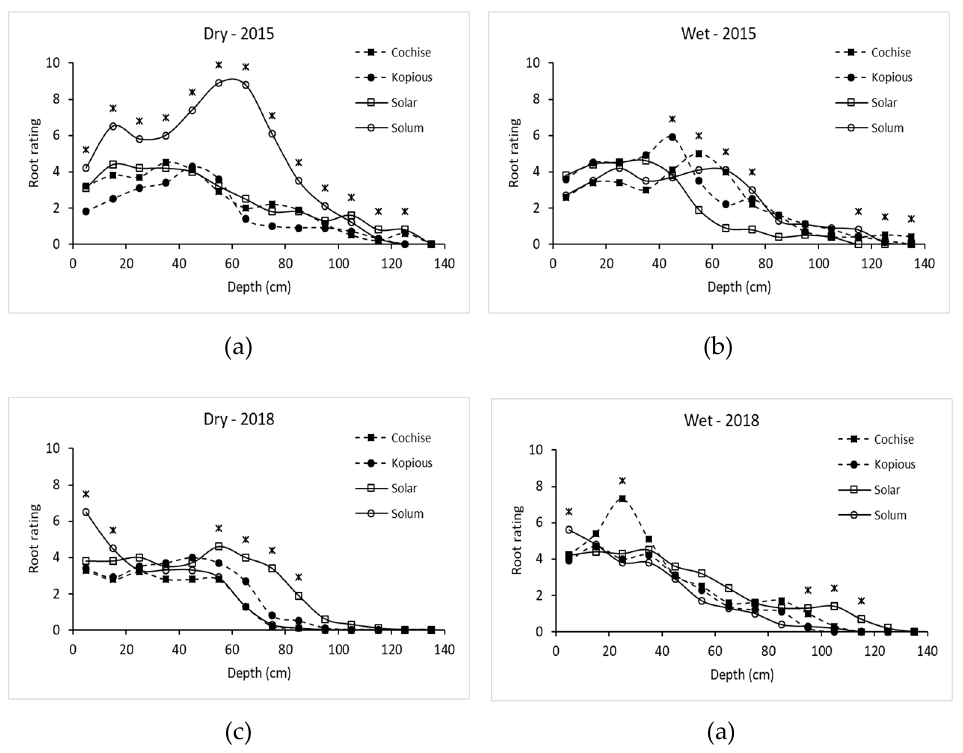
Figure 3. Root density ratings at depths from profile walls dug at physiological maturity by low irrigation (LI) or high irrigation (HI) treatment and year: ( a ) LI 2015; ( b ) HI 2015; ( c ) LI 2018; and ( d ) HI 2018. Crossmark “ × ” indicates significant differences in root density at p < 0.05.